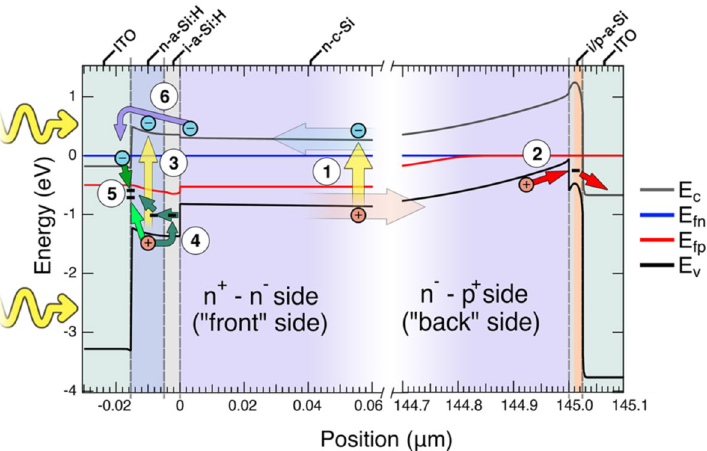
Figure 7. Band diagram sketch from TCAD-SENTAURUS simulation of the complete device SC1 under yellow light illumination corresponding to a current density of 2 mA/cm 2 ; the n and p quasi-Fermi levels are shown as blue and red lines, respectively. The band bending at the front side is not noticeable on the scale presented. Circled numbers highlight the noise processes contributing to the noise spectra: (1) photogenerated carriers